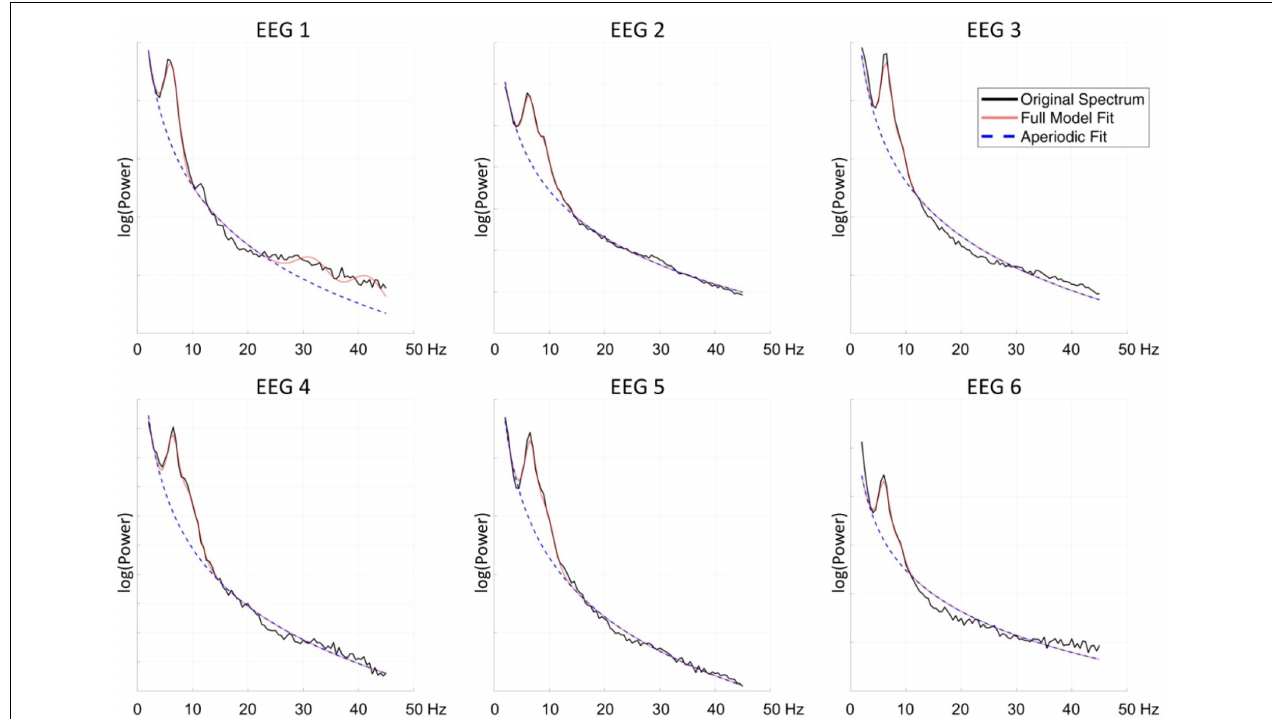
FIGURE 2 | The spectral profiles of all six measurements from the centro-parietal channel. Black line indicates the original spectrum, the red line the fitted function obtained with FOOOF algorithm, and the blue dashed line the fitted aperiodic component.